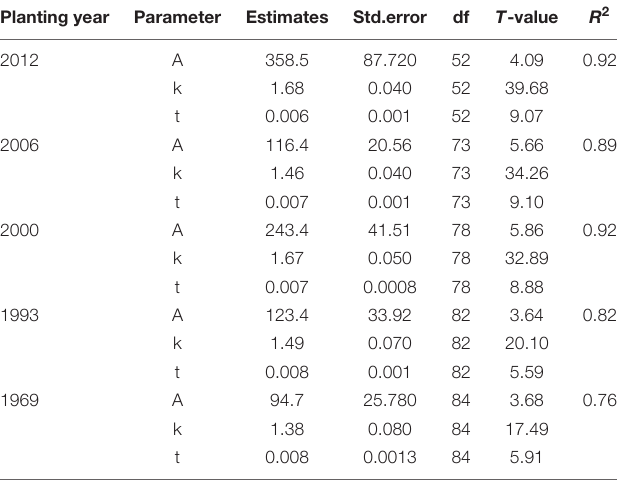
TABLE 2 | Parameter estimates and their standard errors of the model for the number of cells produced during wood cell development of Chinese fir plantations using the Gompertz equation. Planting year Parameter Estimates